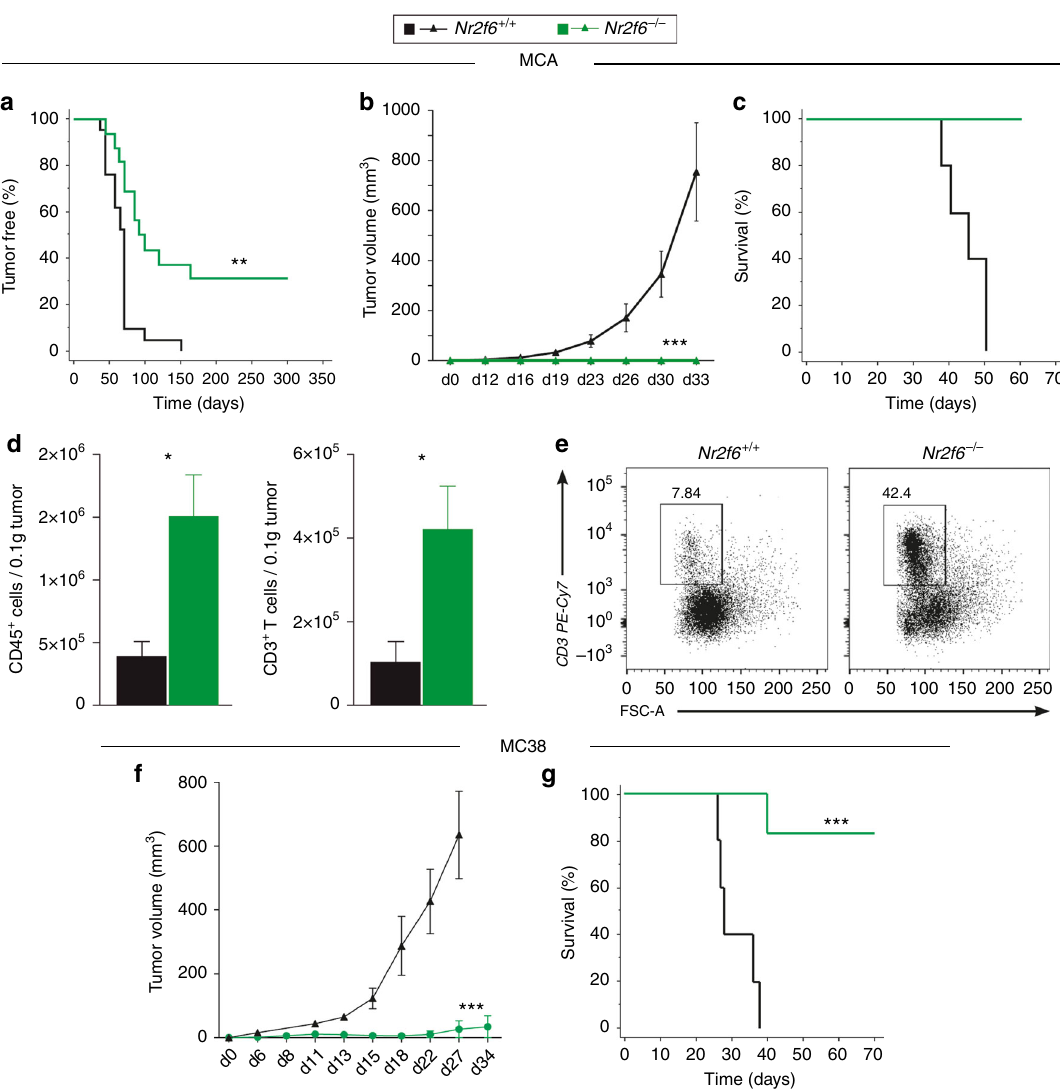
Fig. 1 Nr2f6 − / − mice reject transplantable chemically and induced subcutaneous tumors. a Wild-type ( n = 15) and Nr2f6 -de fi cient ( n = 18) mice were injected with 200 µ g MCA and monitored over 300 days; the percentage of sarcoma-free mice is shown ( p = 0.0007, ANOVA). From the MCA-induced pool of mice, several cell lines were generated. Tumor growth ( b ) and survival ( c ) of one representative wild-type tumor cell line re-injected into wild-type and Nr2f6 − / − mice ( n = 6) with 1×10 6 cells/mouse is shown ( p <0.0001, b ANOVA, c log-rank test). d Signi fi cantly enhanced absolute cell numbers of tumor-in fi ltrating CD45 + leukocytes ( p = 0.018, unpaired t- test, n = 5) and CD3 + T cells ( p = 0.031, unpaired t -test, n = 5) per 0.1 g of tumor tissue in wild-type (black) and Nr2f6 − / − (green) mice spontaneously developing chemically induced (MCA) sarcomas. e Representative dot blots of tumor- in fi ltrating CD3 + T cells from Nr2f6 + / + or Nr2f6 − / − mice are depicted. Numbers adjacent to outlined areas indicate the percentage of positive cells relative to parental CD45 + gate. Summary of 2 − 3 independent experiments is shown and data are expressed as the mean ± SEM. f The kinetics of tumor cell growth in Nr2f6 + / + ( n = 12, black) and Nr2f6 − / − ( n = 6, green) mice subcutaneously injected with 5×10 4 MC38 colon carcinoma cells ( p < 0.0001, ANOVA) as well as g signi fi cant survival bene fi t in Nr2f6 − / − by a Kaplan-Meier curve are shown, and statistically analyzed by a log rank test ( p =